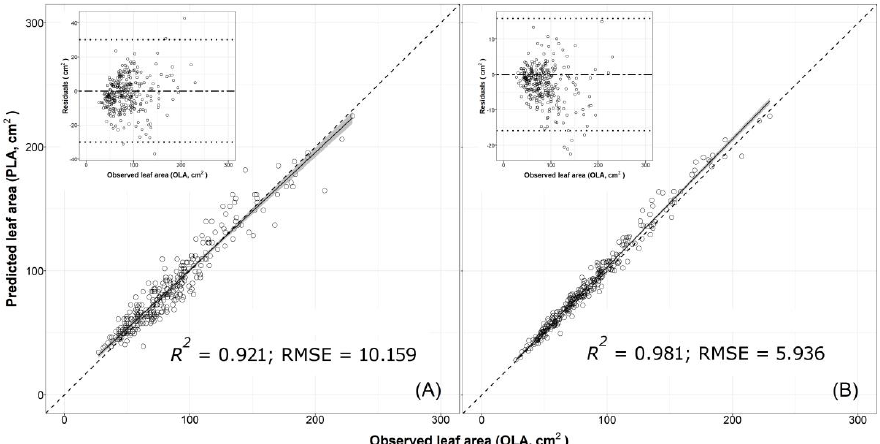
Figure 2. Plot of predicted leaf area (PLA) estimated using ( A ) one-regressor bootstrapped model 6 [LA = 14.003 + 1.742 × W2] and ( B ) two-regressors bootstrapped model 7 [LA = − 0.526 + 0.667 × (L × W)] versus observed values of single leaf areas (OLA) of cv. ‘Tanaka’ collected during 2016 (validation experiment). The solid line and the grey area represent, respectively, linear regression lines of the bootstrapped models 6 and 7 and generalised linear smoothing. R 2 and root mean squared error (RMSE) are also reported. Dotted lines represent the 1:1 relationship between the predicted and observed values. The analysis of the dispersion pattern of residuals for models 6 and 7 are shown in the insets. Residuals = the di ff erence between predicted leaf areas (PLA) estimated by model 6 or 7 (with coe ffi cients obtained from pooled data from nine loquat cultivars, see Table 4 for more details) versus the observed leaf area of ‘Tanaka’ cultivar sampled in 2016 (validation experiment). The solid line is the mean of the di ff erences. The broken lines are the limits of agreement, calculated as d ± 3 SD (standard deviation); where d is the mean of the di ff erences, and SD is the standard deviation of the di ff erences. If the di ff erences are normally distributed, 97% of the di ff erences in a population will lie between the limits of